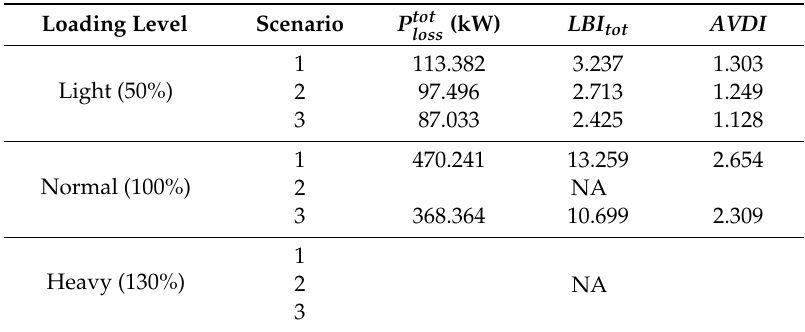
Table 5. Total power losses and PQ indices for scenarios 1, 2 and 3: 83-node system.